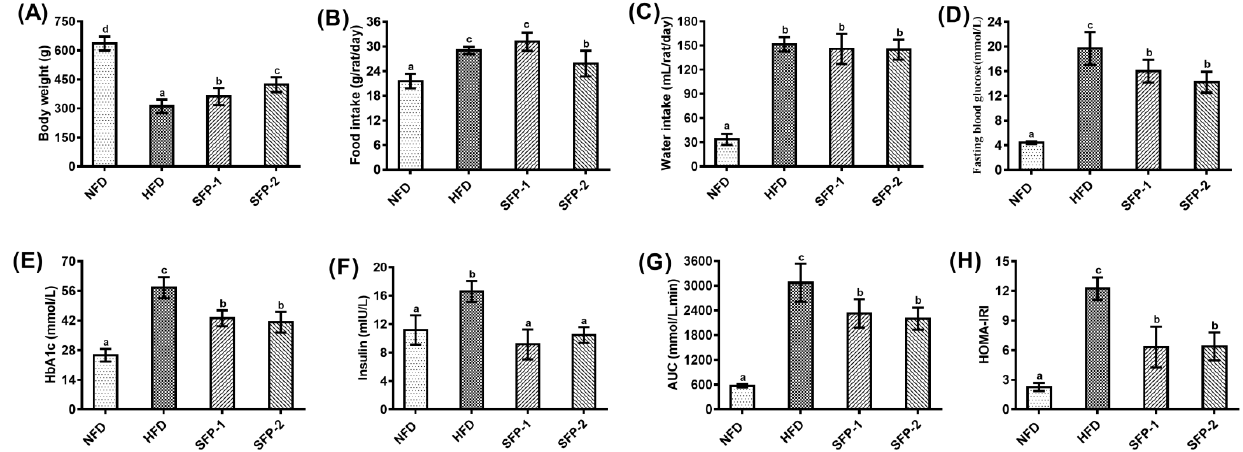
Figure 1. Effects of SFPs on blood glucose after starch loading ( A ) and glucose loading ( B ) in rats. The different letters represent significant differences ( p < 0.05).